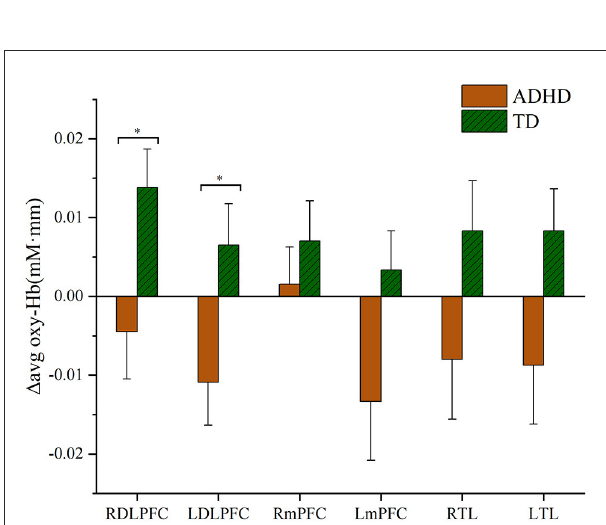
FIGURE3 Hemodynamic changes during the performance of the go/no-go task. RDLPFC, right dorsolateral prefrontal cortex; LDLPFC, left dorsolateral prefrontal cortex; RmPFC, right medial prefrontal cortex; LmPFC, left medial prefrontal cortex; RTL, right temporal lobe; LTL, left temporal lobe. * p <